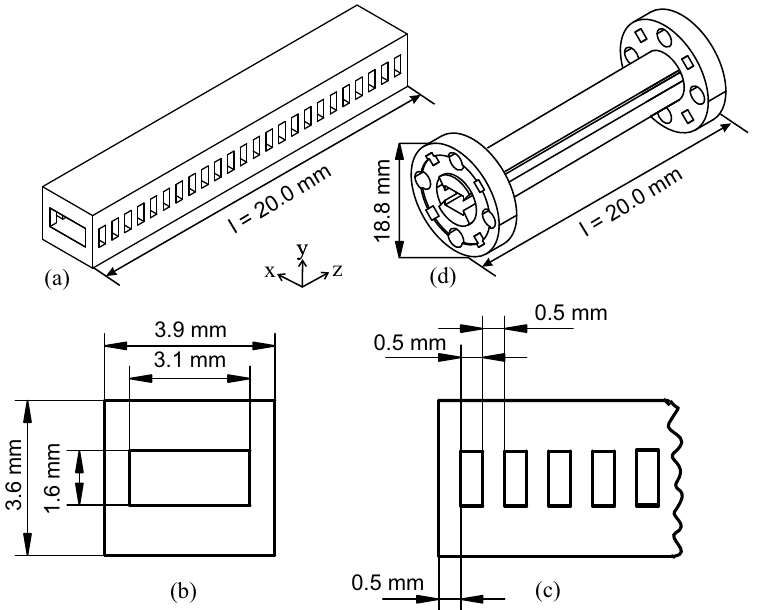
Figure 1. CAD model ( a – c ) of the proposed WR12 waveguide. The waveguide in ( a – c ) can be mounted in an additional fixture ( d ) which provides flanges for measurements with a